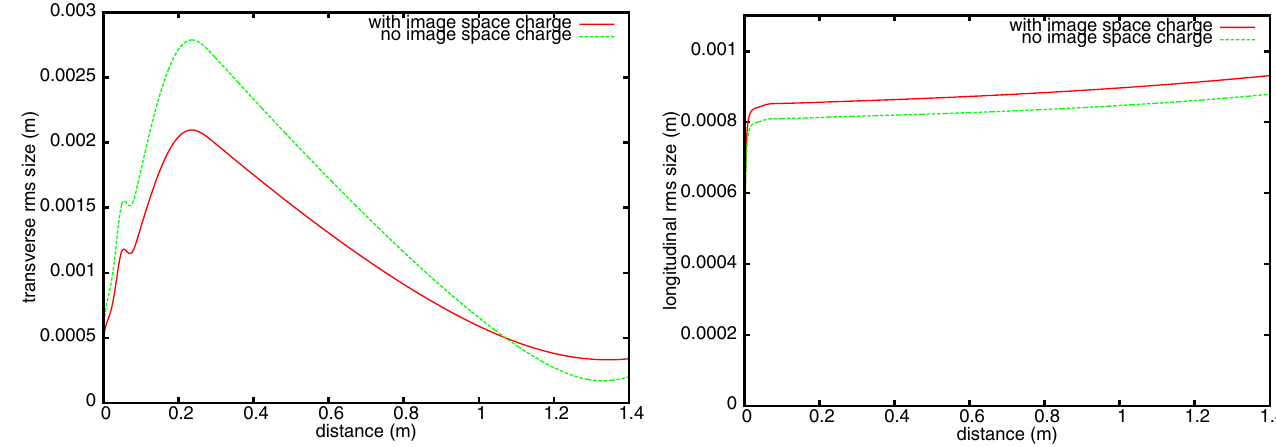
FIG. 3. (Color) Transverse (left) and longitudinal (right) rms sizes as a function of distance with and without the image-charge effects from